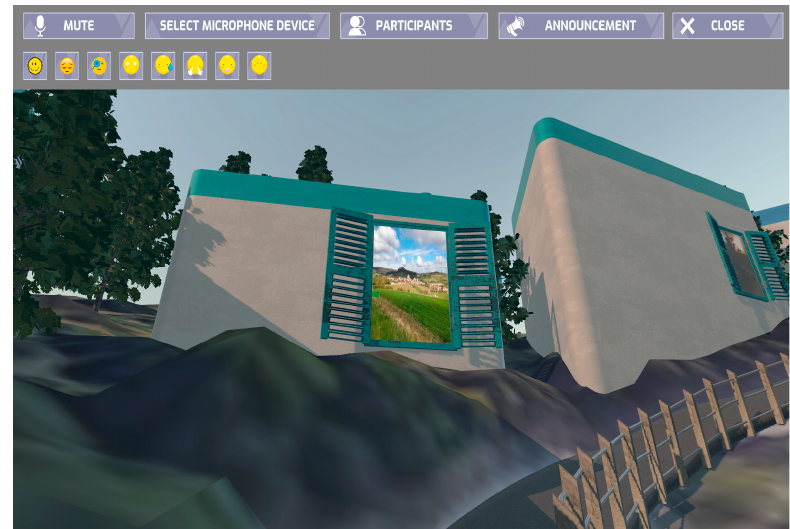
Figure 7. Cap de Ballon, ( a ) outdoors view and ( b ) indoors view.